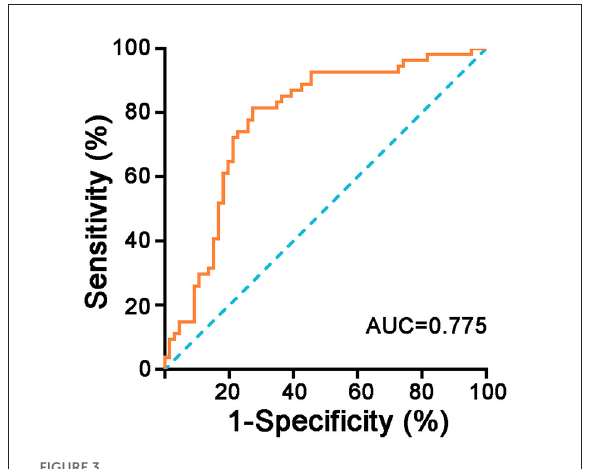
FIGURE3 ROC curve of SI for predicting PTCI in patients with TBI brain herniation. The receiver operating characteristic (ROC) curve showed that the area under the curve was 0.775 (95% CI = 0.689–0.861, P <